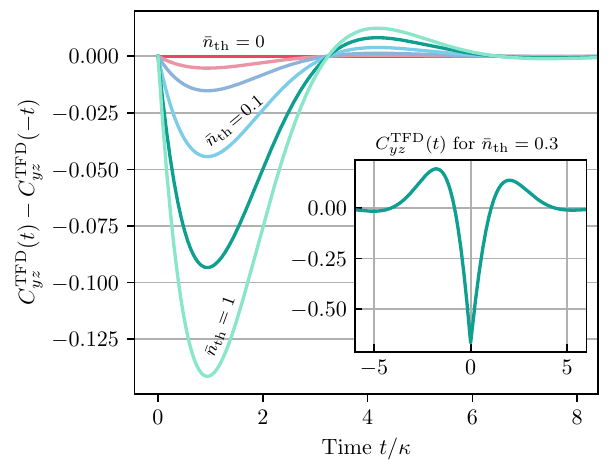
FIG. 7. Hidden-TRS breaking in a driven qubit. Inset: the doubled-system TFD σ y - σ z connected correlation function ( t ) [cf. Eq. (16)] as a function of time, for a Rabi-driven- C TFD yz dissipative qubit for a nonzero temperature corresponding to = 0.3. The TFD state is defined by the hidden-TRS opera- ¯ n th tor ˆ T [cf. Eq. (34)]. Main plot: the time asymmetry of the TFD ( t ) − C th ( − t ) versus time t for various correlation function C th yz yz temperatures. The values of ¯ n th are in order from top to bottom: 0, 0.01, 0.03, 0.1, 0.3, and 1. The ¯ n th = 0 trace is identically zero, which reflects the presence hidden TRS at zero temperature. The onset of asymmetry heralds the breaking of hidden TRS with the introduction of thermal fluctuations. All functions are computed for a resonant Rabi drive with amplitude (cid:11) = κ( 1 + 2 ¯ n th ) , where κ is the loss